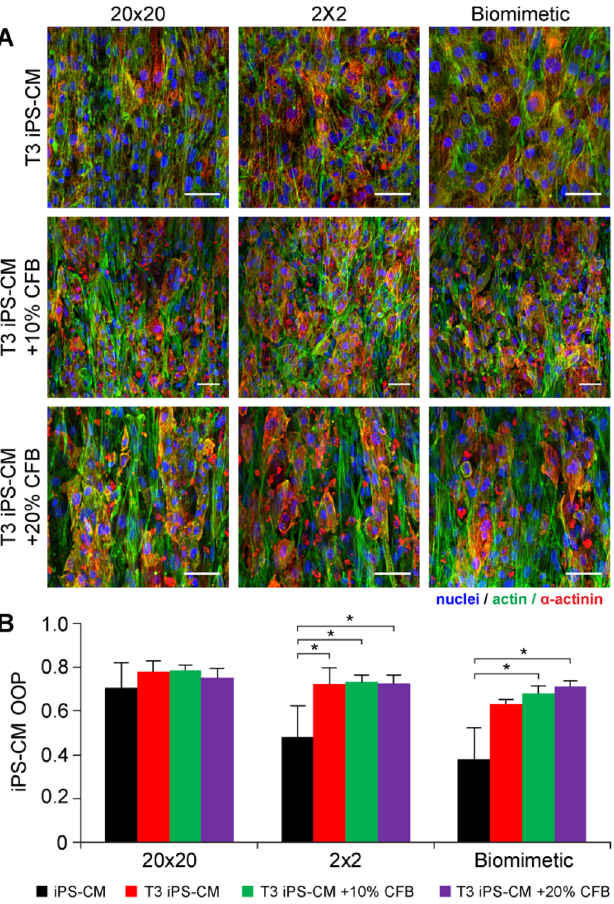
Figure 6. Understanding the relative role of CFB and T3 hormone on the alignment of iPS-CMs on the fibronectin micropatterns. ( A ) Representative images of iPS-CMs cultured on the fibronectin micropatterns with T3 hormone and with either 0%, 10%, or 20% CFBs. CFBs can be distinguished from cardiomyocytes by the lack of α-actinin (red) staining. Scale bars are 50 µm. ( B ) Alignment analysis of T3-matured iPS-CMs shows that T3-maturation significantly increases iPS-CM OOP on the 2 × 2 and biomimetic patterns. Interesting, the combination of CFBs and T3 hormone has no significant effect on alignment. One-way ANOVA with Tukey post hoc for each pattern, *indicates p < 0.05, n ≥